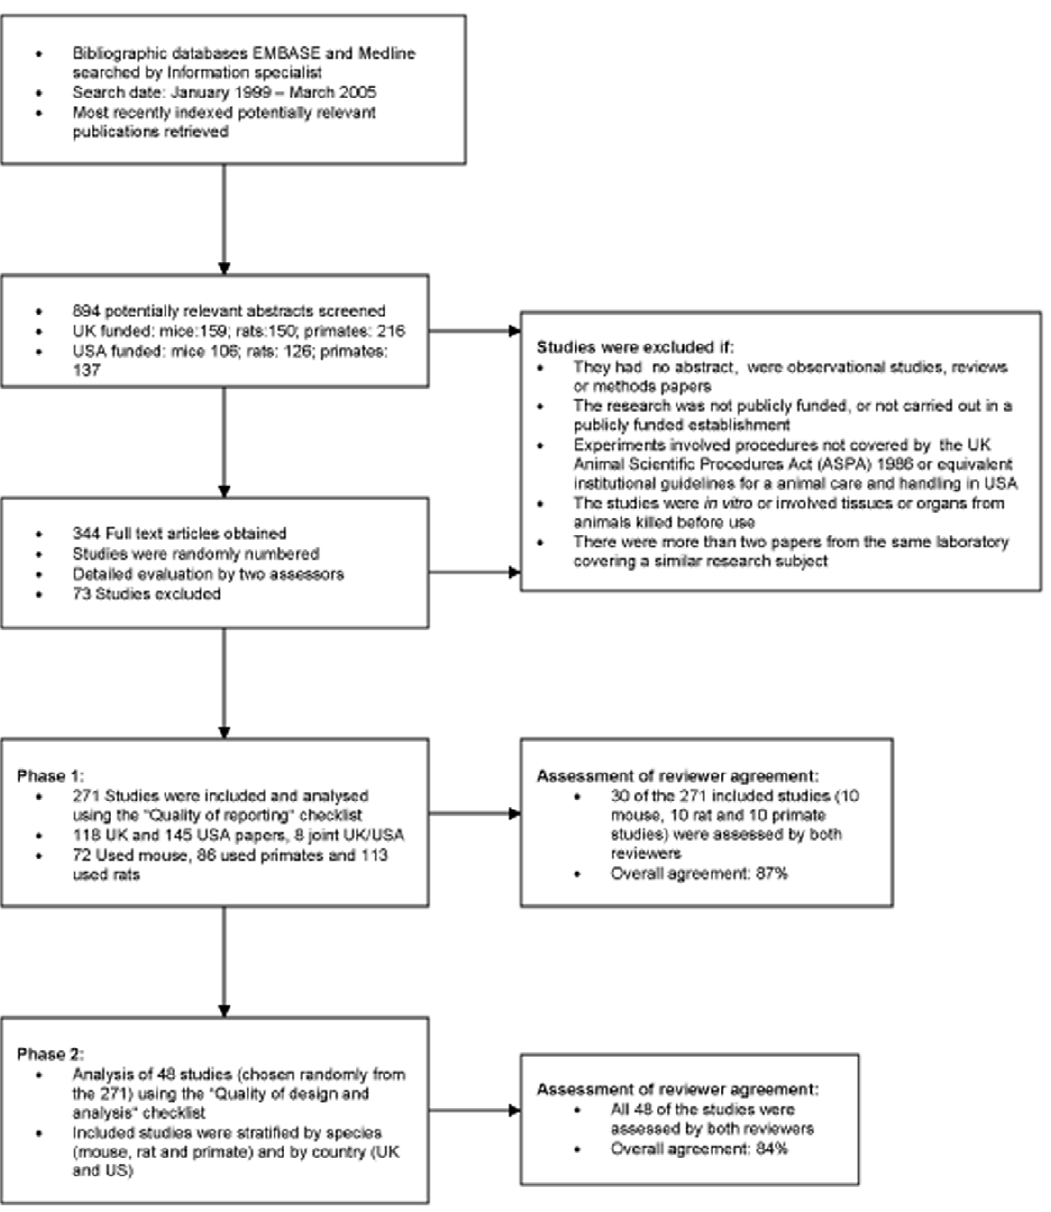
Figure 1. Flow diagram summarising the survey methods.